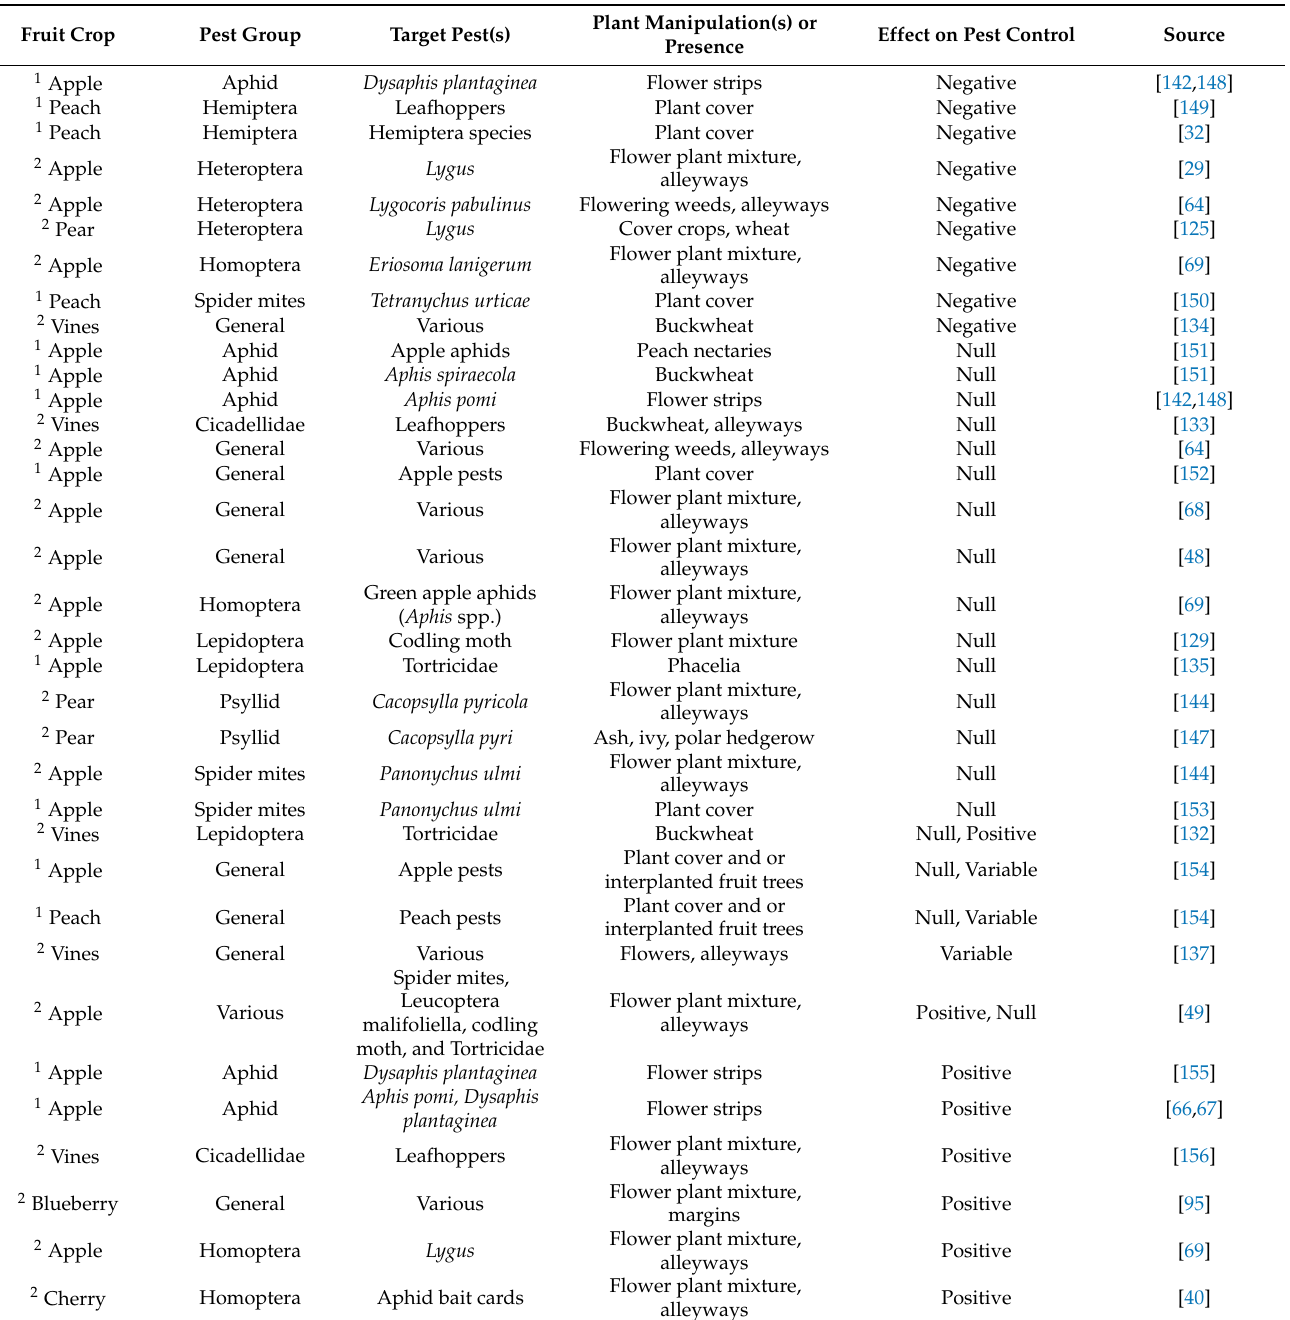
Table 2. Effects of wildflower of cover crop floral enhancements on the control of fruit pests, updated from Simon et al. [124] 1 and updates 2 . The effect of plant manipulation on pest control is considered to be positive, null, or negative when either the density of the pest arthropod of the fruit tree, fruit damage, and/or the number of pesticide applications against the target pest is lower, equal to, or higher, respectively, compared with the control. NB: different effects may be due to species growth, location, or